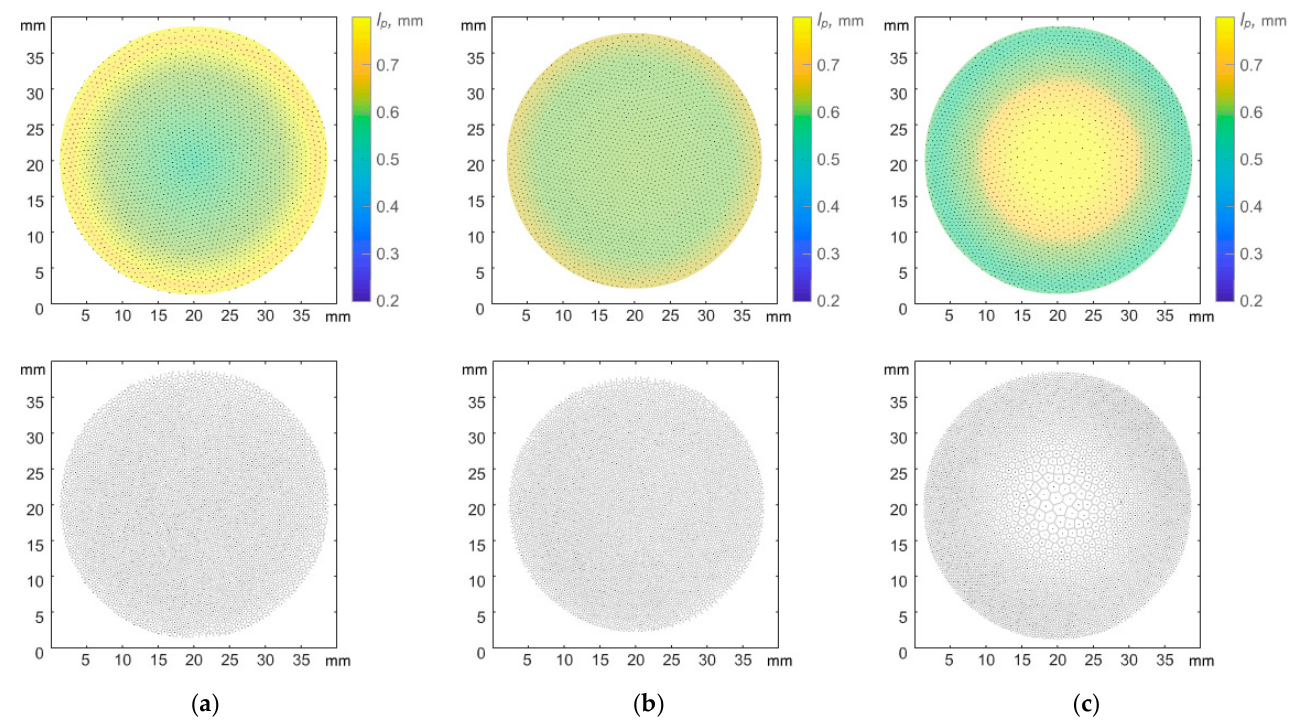
Figure 2. Quasi-two-dimensional dust structures in argon plasma of RF discharge at P = 5 Pa and various values of discharge power W: ( a ) 4.4 W, ( b ) 6.9 W, ( c ) 16.7 W. Color bar shows radial distribution of interparticle distances (upper row), Voronoi diagrams (lower row) represent different degrees of structure inhomogeneity.